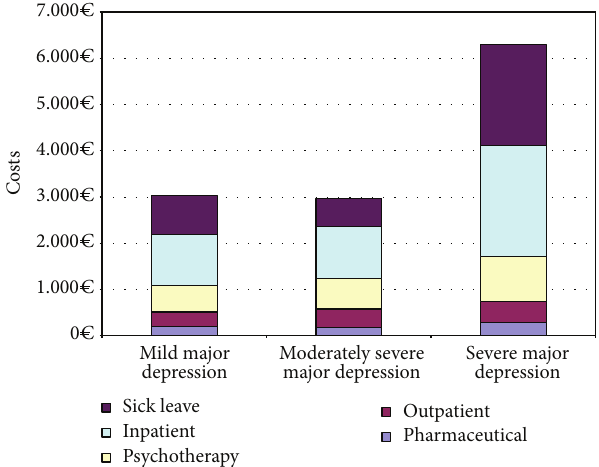
Figure 1: Total disease-related cost per patient by severity.